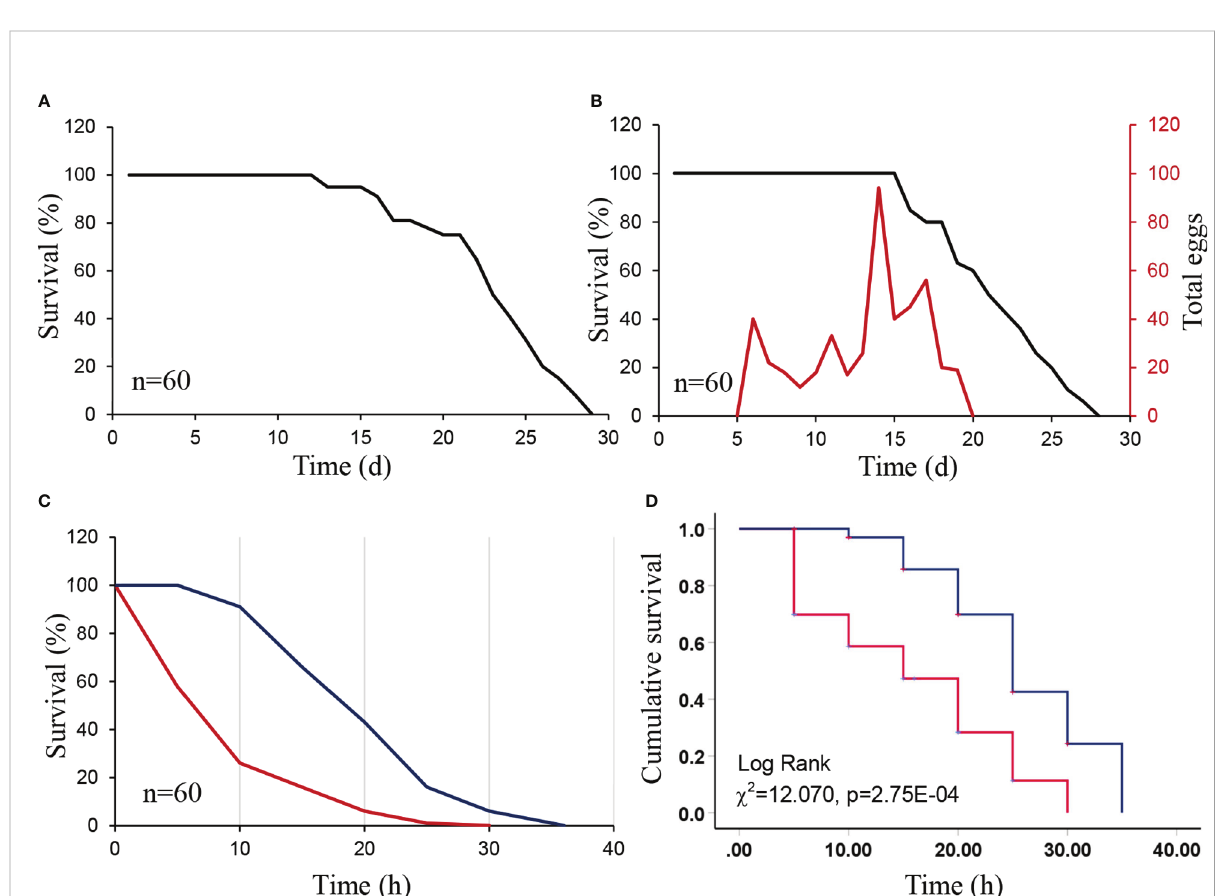
FIGURE 1 Survival curve and cumulative survival functions of Diaphorina citri adults over time when feeding on Nicotiana tabacum and a preferred host Murraya exotica (positive treatment). We also included a starvation treatment as a negative control. (A) Survival curve of male D. citri adults feeding on M. exotica . (B) Survival and fecundity curves of female D. citri adults feeding on M. exotica . (C) Survival curves of D. citri adults feeding on N. tabacum (red line) and starved (blue line). (D) Cumulative survival functions of D. citri adults on N. tabacum (red line) and the starved (control, blue line).